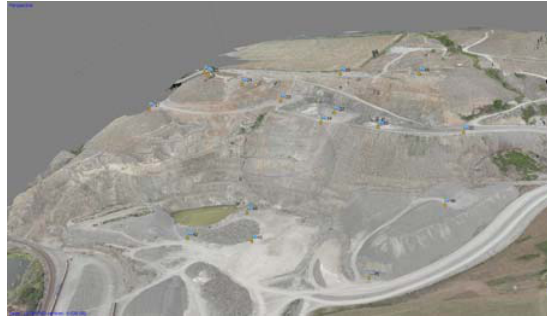
Figure 6. 3D perspective view of 60 million point DSM generated from 985 photos in Agisoft PhotoScan